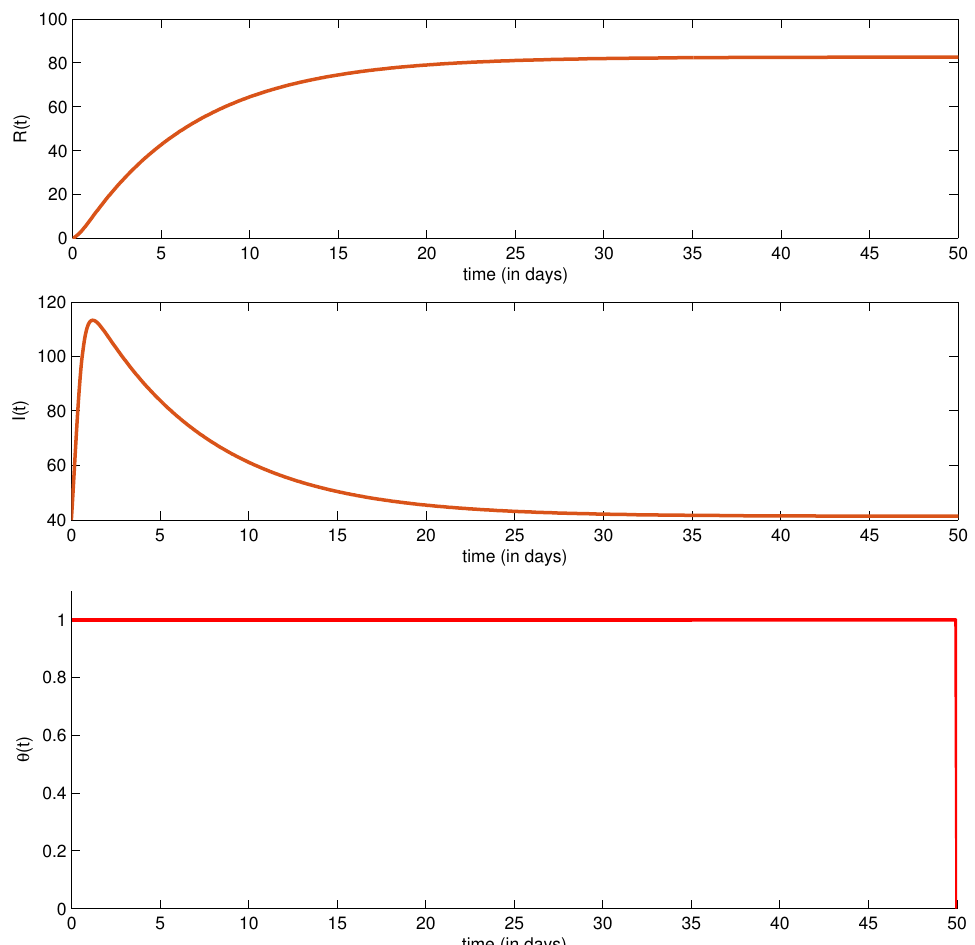
Figure 4. Infection and recovery behavior in presence of continuous-time control as in (2), with a = 0.5, b = 10 − 5 and β =